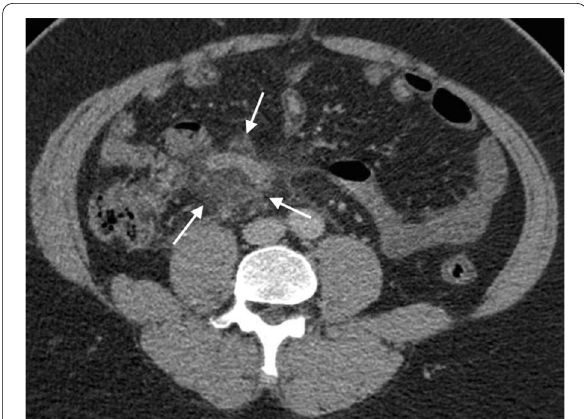
Fig. 4 Moderate-to-severe periappendiceal fat stranding. An axial CT image of a 40-year-old man presenting with a 48-h onset of right lower quadrant pain, elevated white blood cell counts (14,010 cells/ mm 3 ) and neutrophilia (85.2% neutrophils) shows a dilated appendix